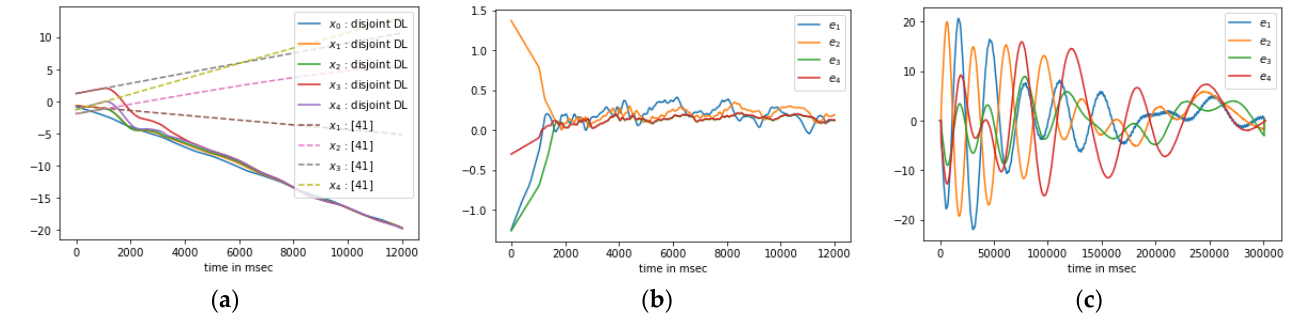
Figure 6. Comparison of the disjoint DL with the RL-based algorithm by Li, 2021 ( a ) state trajectory for case 1; ( b ) disagreement error of the disjoint DL for case 3; ( c ) disagreement error of the RL-based algorithm in [41] for case 3. Table 5. The execution time for training and for inference for 1000,000 examples .